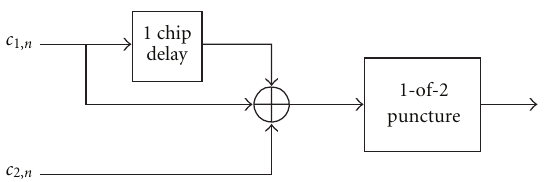
Figure 3: Logic diagram for processing the result from the sequential processing of the complex